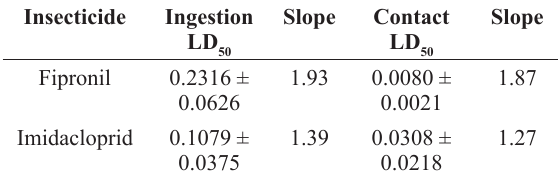
Mean ingestion and contact lethal doses (LD bee) and slopes in the probit analysis of the insecticides fipronil and imidacloprid for African-derived Apis mellifera